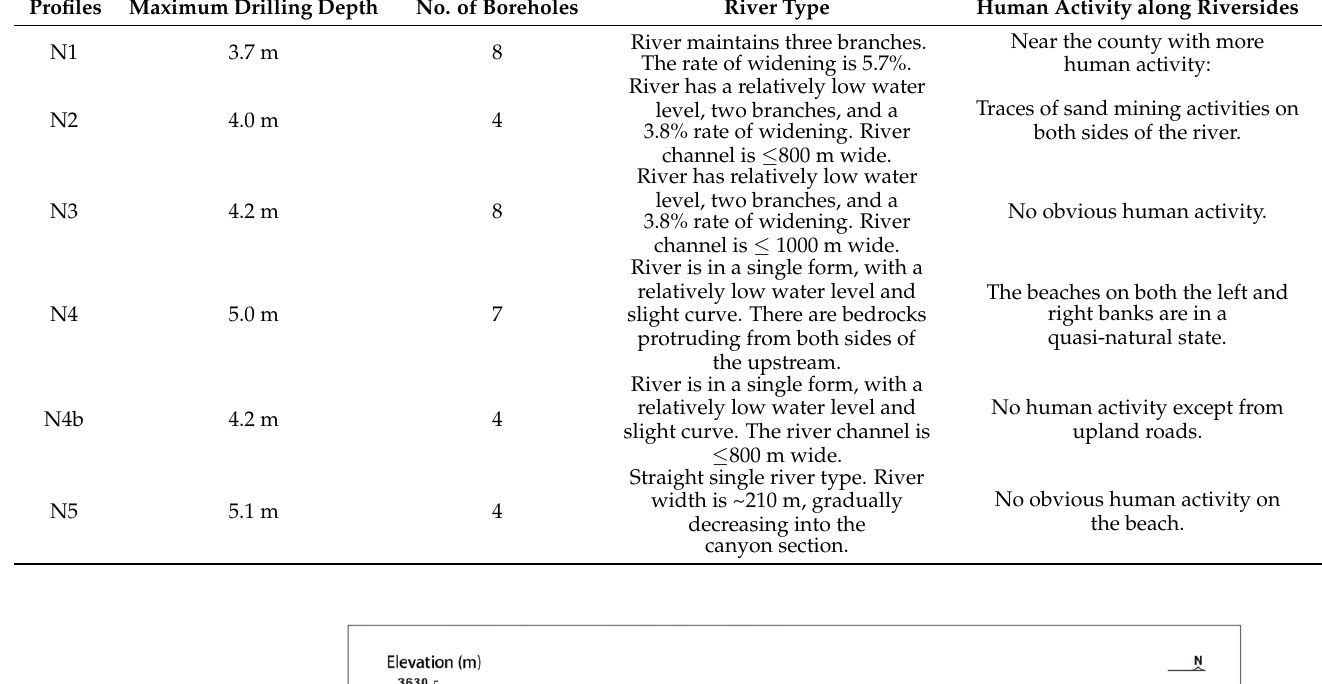
Table 1. Description of river type and boreholes in each section.